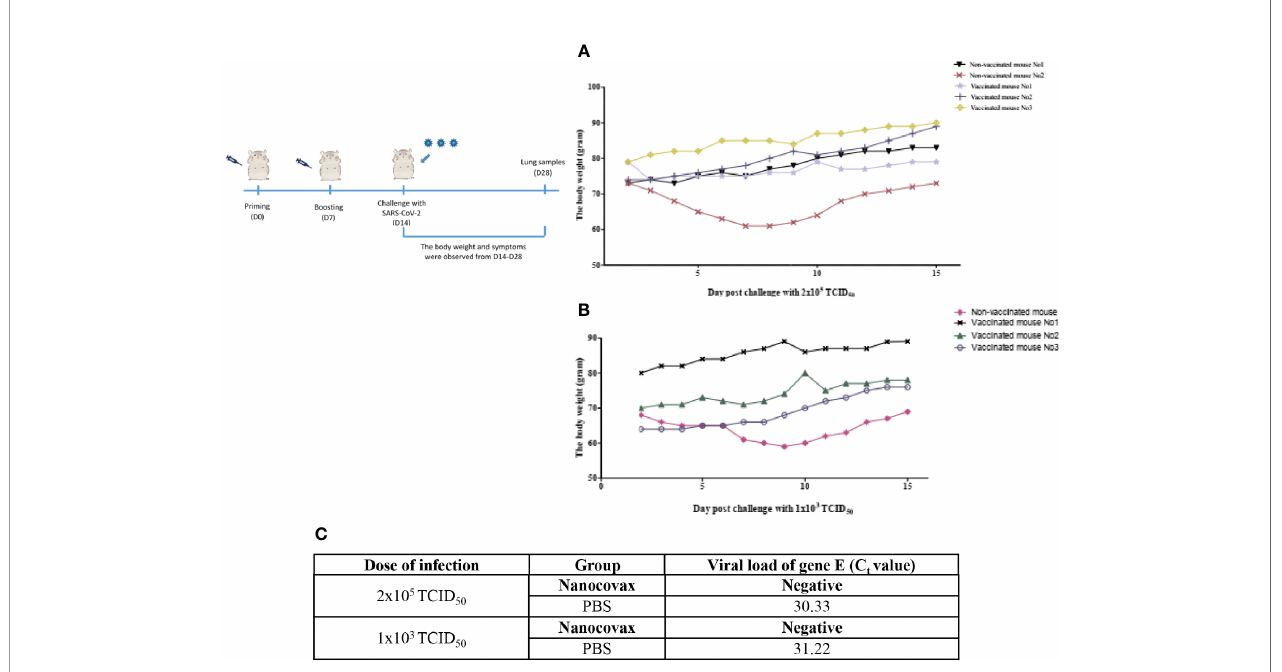
FIGURE 5 | Challenge of Syrian hamsters with live SARS-CoV-2. Syrian hamsters were vaccinated twice 7 days apart. After vaccination, the hamsters were challenged with low and high levels of the SARS-CoV-2 virus on day 14. The weight gain in hamsters was monitored after challenge with high (A) and low levels of SARS-CoV-2 (B) . SARS-CoV-2 load [ envelope (E) gene] in lung samples 14 days post challenge was determined by real-time RT-PCR (C)